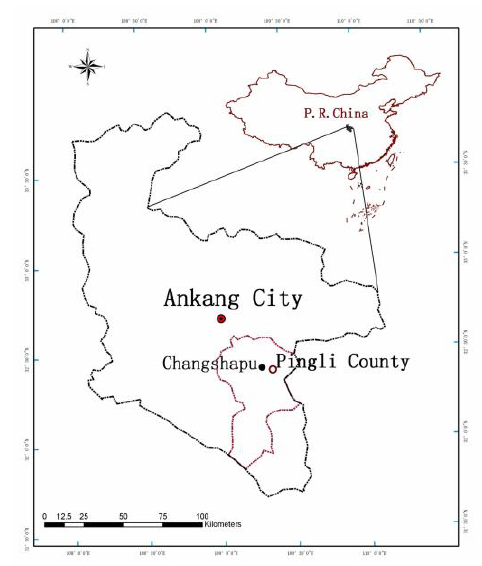
Figure 1. Map of the study